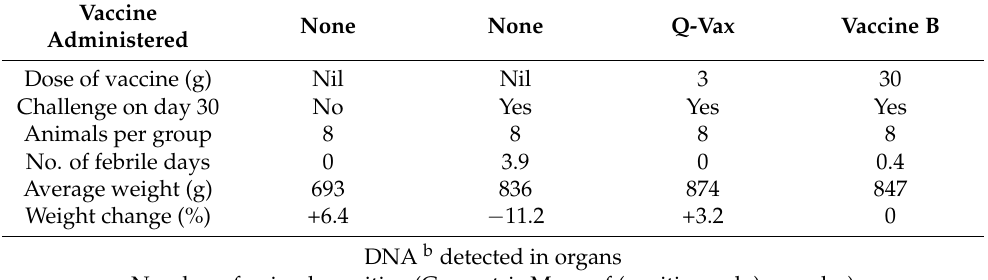
Table 5. Protection induced by Vaccine B a measured by febrile response and weight